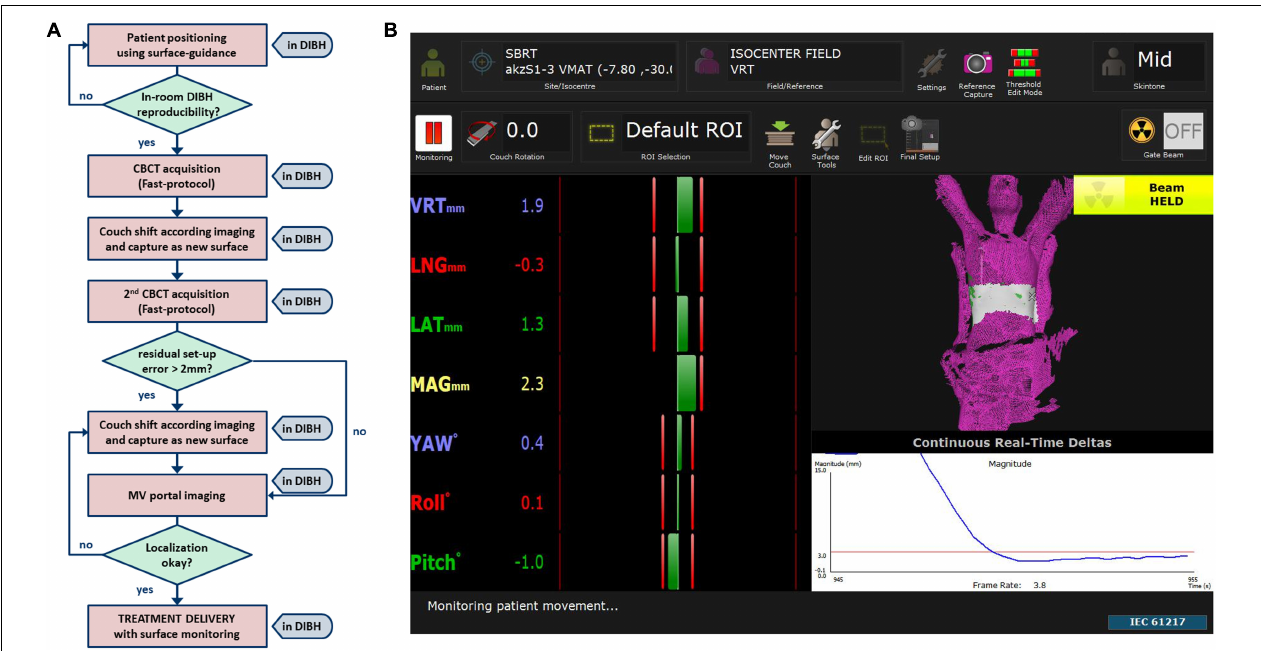
FIGURE 1 | (A) Work flow of patient set-up and localization until treatment delivery together with (B) an example screenshot of one of our SBRT patients showing a typical region of interest (ROI) placed to the lower thorax for DIBH monitoring of a liver target.